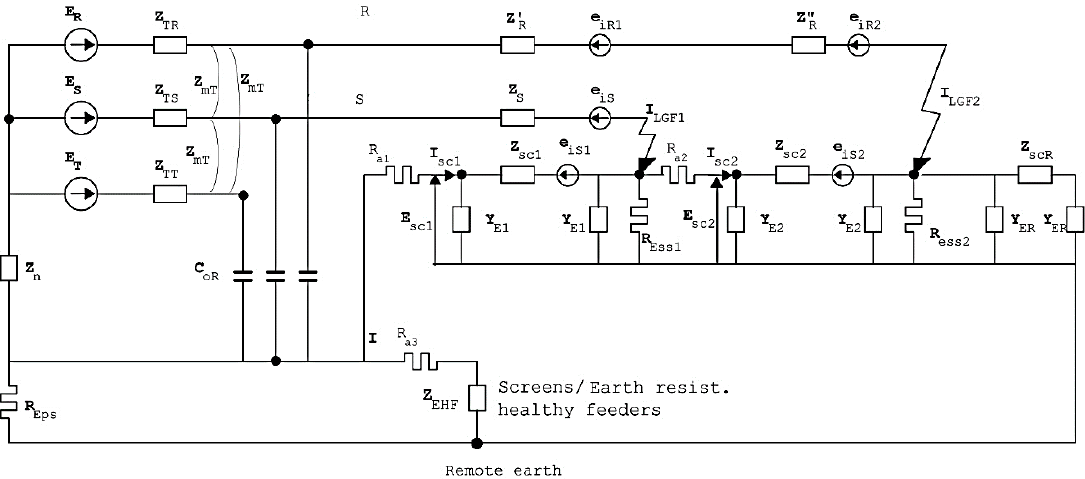
Figure 5. Single line diagram of a MV distribution network with CCF in the same cable line.